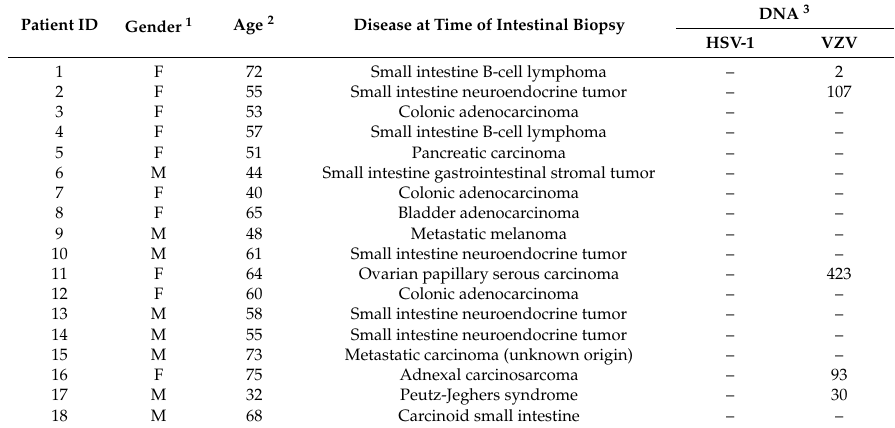
Table 1. Detection of varicella-zoster virus DNA in human intestine